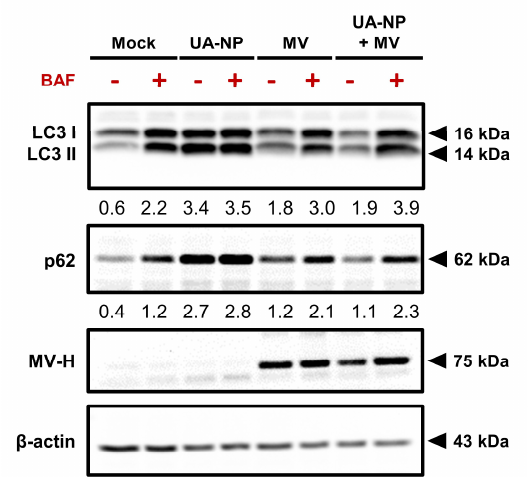
Figure 7. UA-NP and oncolytic MV co-treatment enhances autophagic flux in MCF-7 cells. MCF-7 cells were treated with UA-NP (30 µ M), MV (MOI 0.1), or concurrently with both agents for 48 h before being harvested and analyzed for LC3, p62, MV H protein, and β -actin expression using western blot. Bafilomycin (BAF, 100 nM) was added to the indicated groups 4 h before harvesting the cells. LC3II and p62 signals were quantified and normalized to the β -actin loading